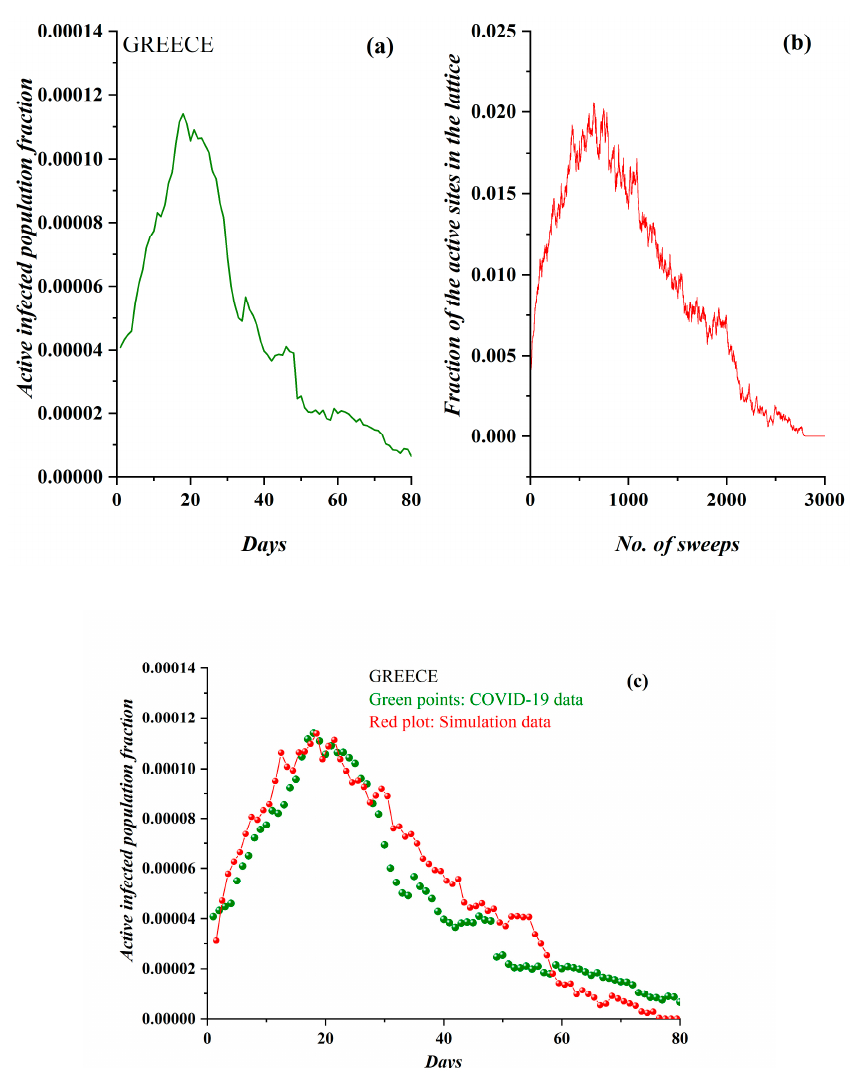
Figure 10. ( a ) The fraction of the active COVID-19-infected population daily in Greece (from 5 March 2020). ( b ) The order parameter of the SODM, namely the fraction of active lattice sites—simulation vs. the number of lattice sweeps—is shown. ( c ) The COVID-19 epidemic data for Greece in green points, fitted by the proposed a self-organized diffusion model (SODM) simulation data, in red points. Each day corresponds to 37 sweeps.